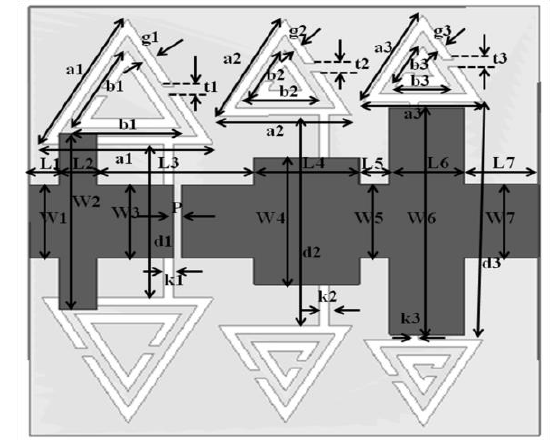
Fig. 9: Proposed design for microstrip low pass filter with triangular CSRR-DGS